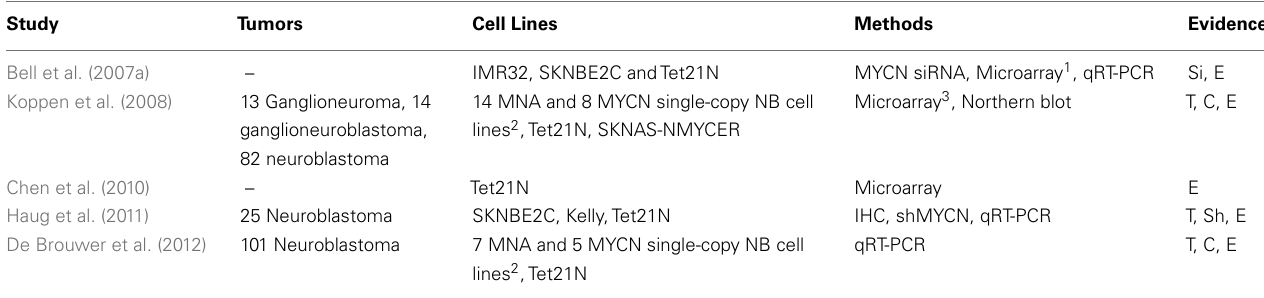
Table 3 | Summary of studies which have observed an inverse relationship between DKK3 expression and MYCN expression and/or MYCN amplification in